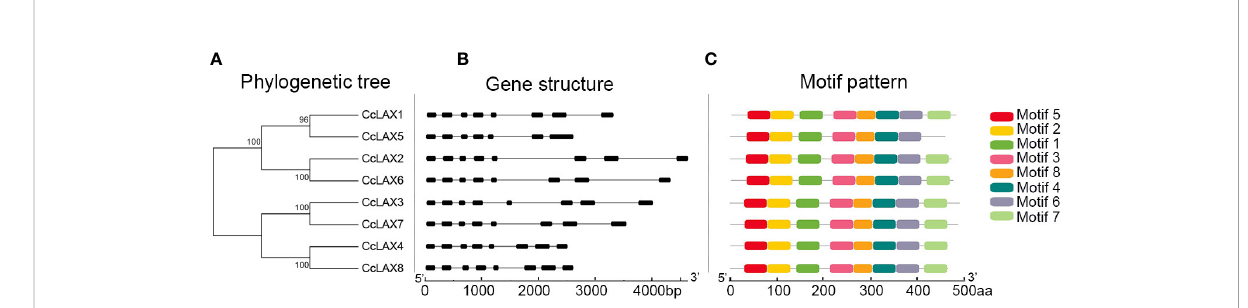
FIGURE 2 Phylogenetic analysis, gene structure and motif pattern in AUX/LAX genes from Chinese hickory. (A) The phylogenetic tree was constructed based on the full-length sequences of CcAUX/LAX proteins using MEGA7 software. (B) The exons are represented by black boxes, and the introns are represented by lines. (C) Motifs of the AUX/LAX proteins were analyzed by the Multiple Expectation Maximization for Motif Elicitation (MEME) web server, different colored boxes mean different